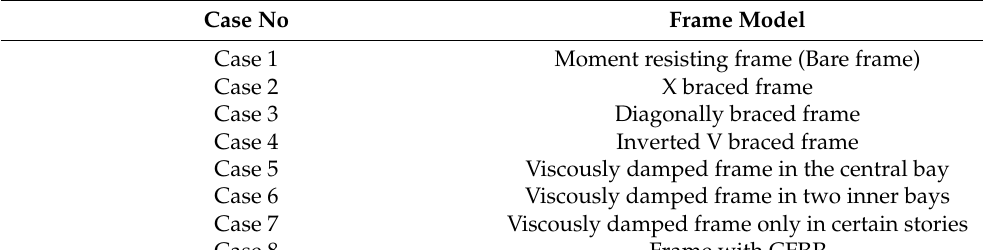
Figure 2. Elevation view of the RC building. Table 1. Definitions for the different frames.